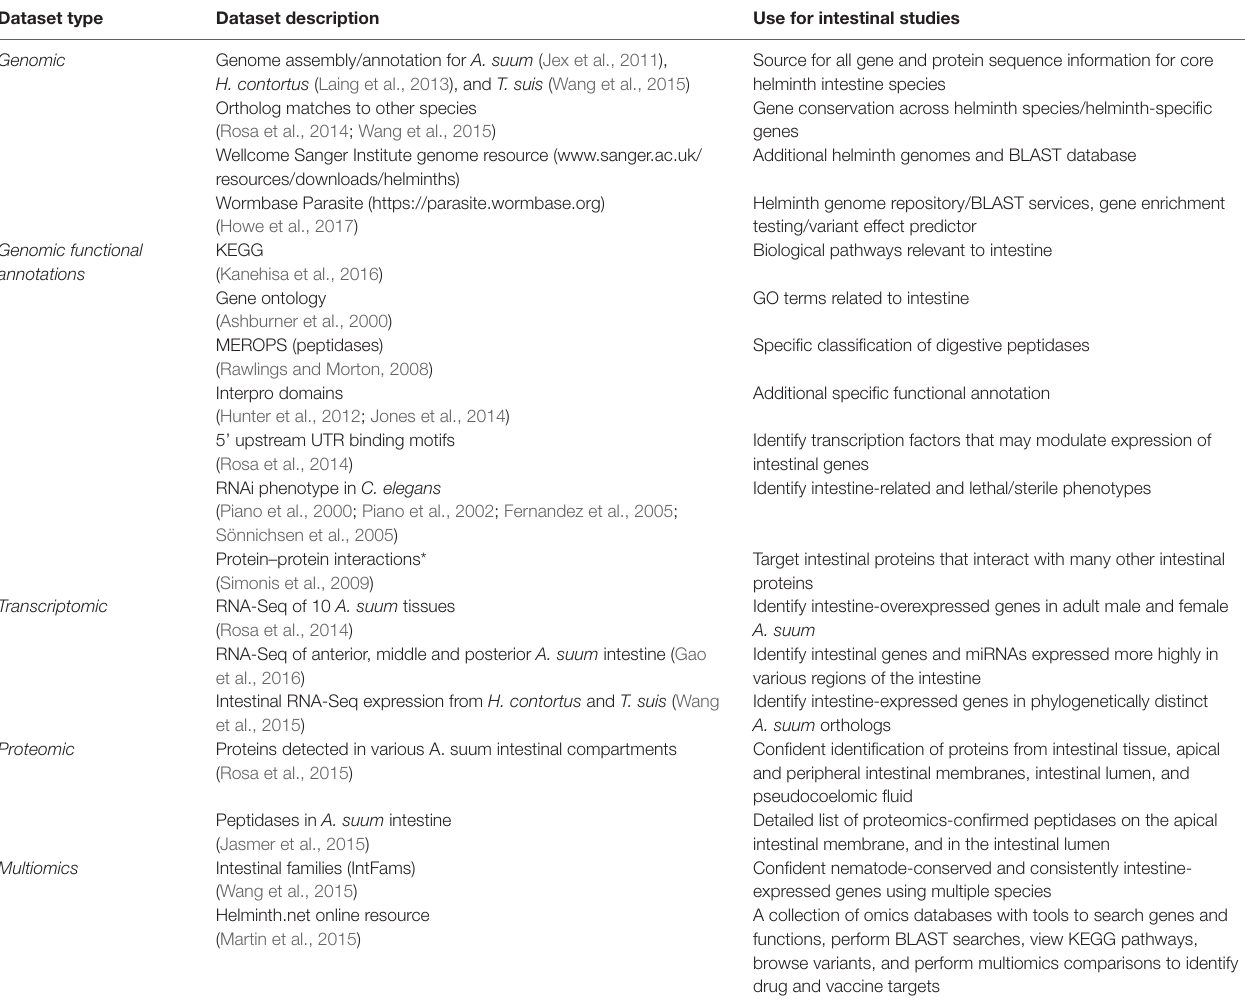
TABLE 2 | Available omics resources useful for the study of the helminth